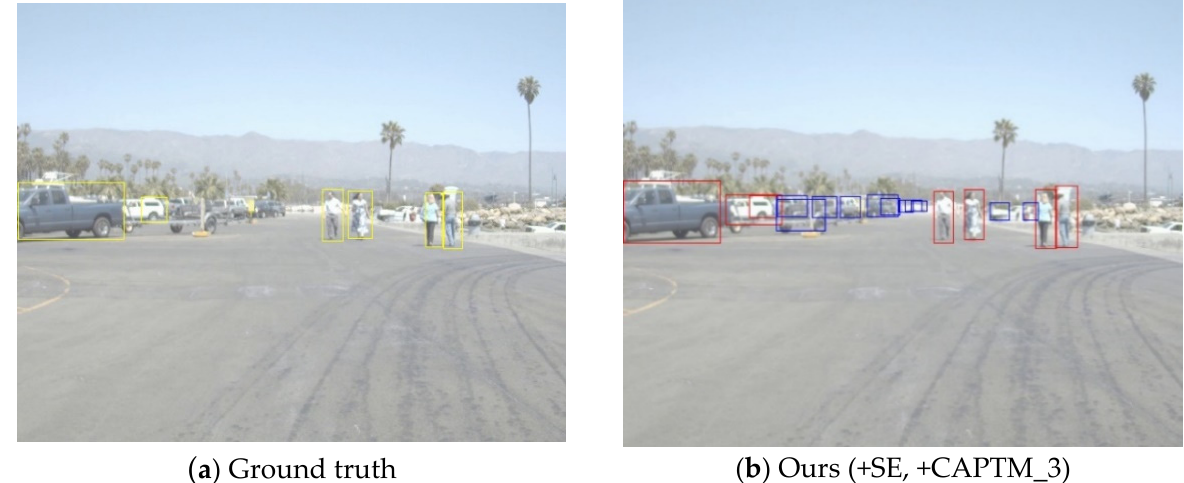
Figure 11. Many vehicles parked on the roadside were not labeled. Red, yellow, and blue respectively represent true-positive, false-negative, and false-positive results.